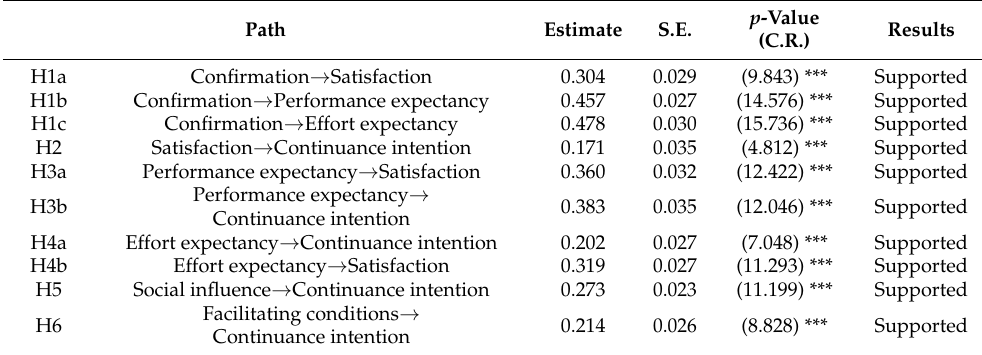
Figure 2. Structural model results. Note: *** p < 0.001; the dotted line represents the insignificant path. Table 6. Results of the hypotheses